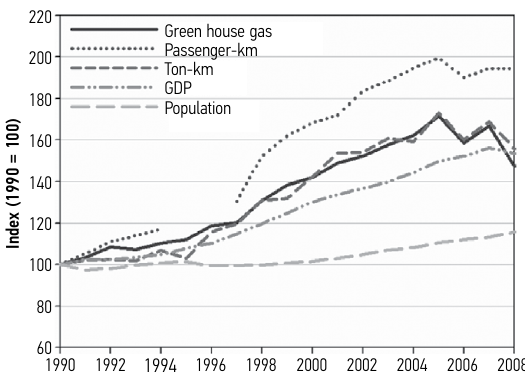
Fig. 2. Relative evolution, according to the figures of 1990, for Spanish transport GHG emissions, passenger and freight performances, GDP and population from 1990 to 2008. Base 100 = year 1990 (Pérez-Martínez et al.